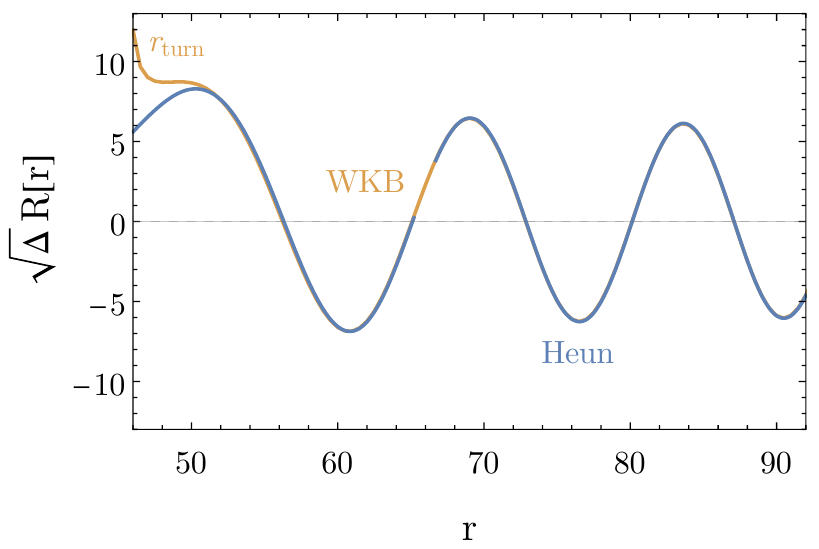
Figure 3 . Comparison of the full radial function and the WKB approximation for Schwarzschild scattering. The exact radial function is taken from eq. (5.16), while the WKB radial function is from eq. (5.6). The WKB function diverges as usual at the classical turning point. Here ∆ = r ( r − 2 GM ) and we’ve taken M = 1 , m = 0 . 1 , k 2 = 0 . 1 m 2 , j = 5 and ~ = 0 . 2 . Smaller values of ~ result in